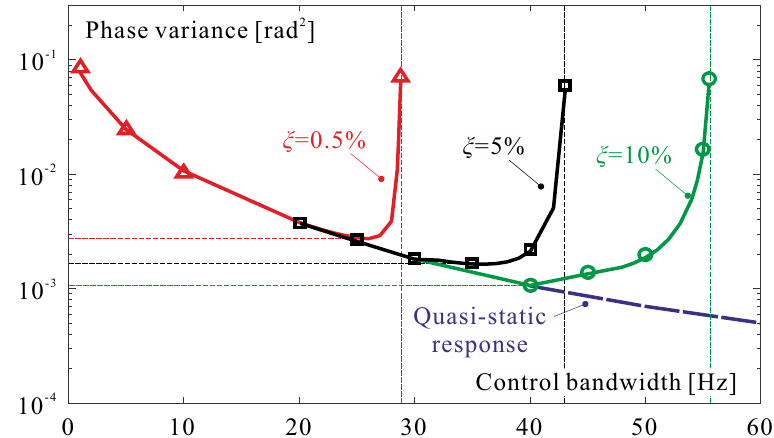
Figure 5. Normalized phase variance residual error, σ 2 ( D / r 0 ) − 5/3 (with tip-tilt removed) when the SH and the dynamics of the mirror are included in the analysis, as a function of the crossover frequency f c of the controller of Figure 4. The deterioration of the performance for larger f c is highly dependent on the structural damping ξ . The first natural frequency of the mirror is f 1 = 208.9 Hz.